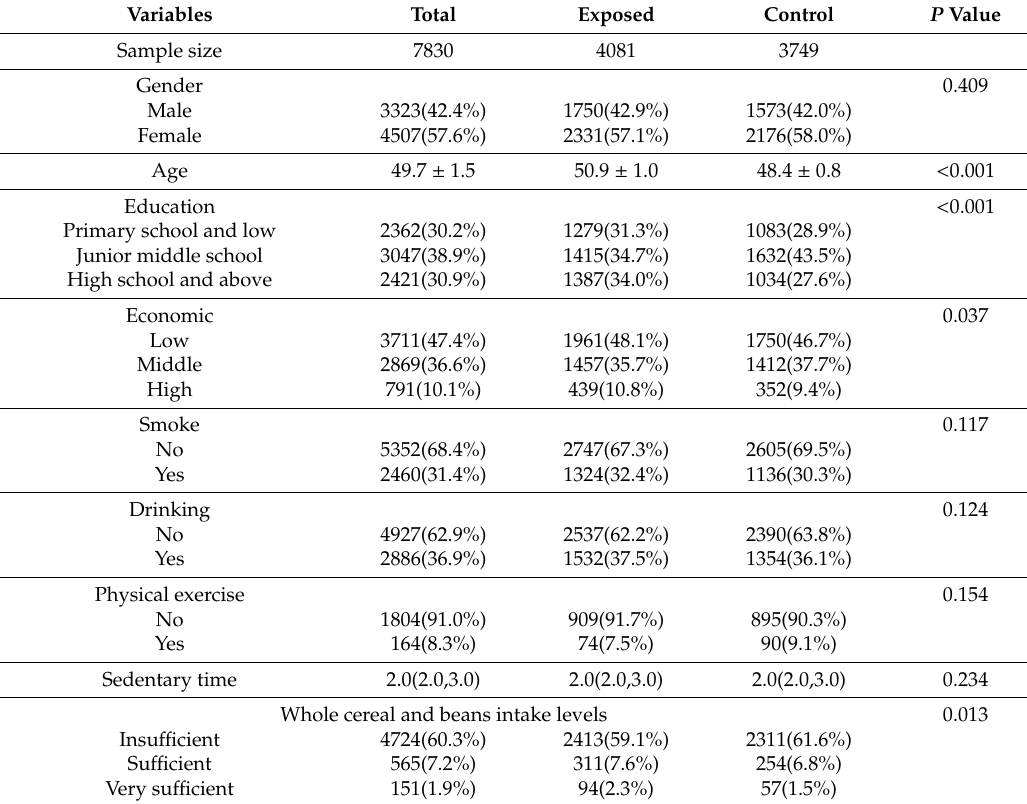
Table 1. General characteristics of